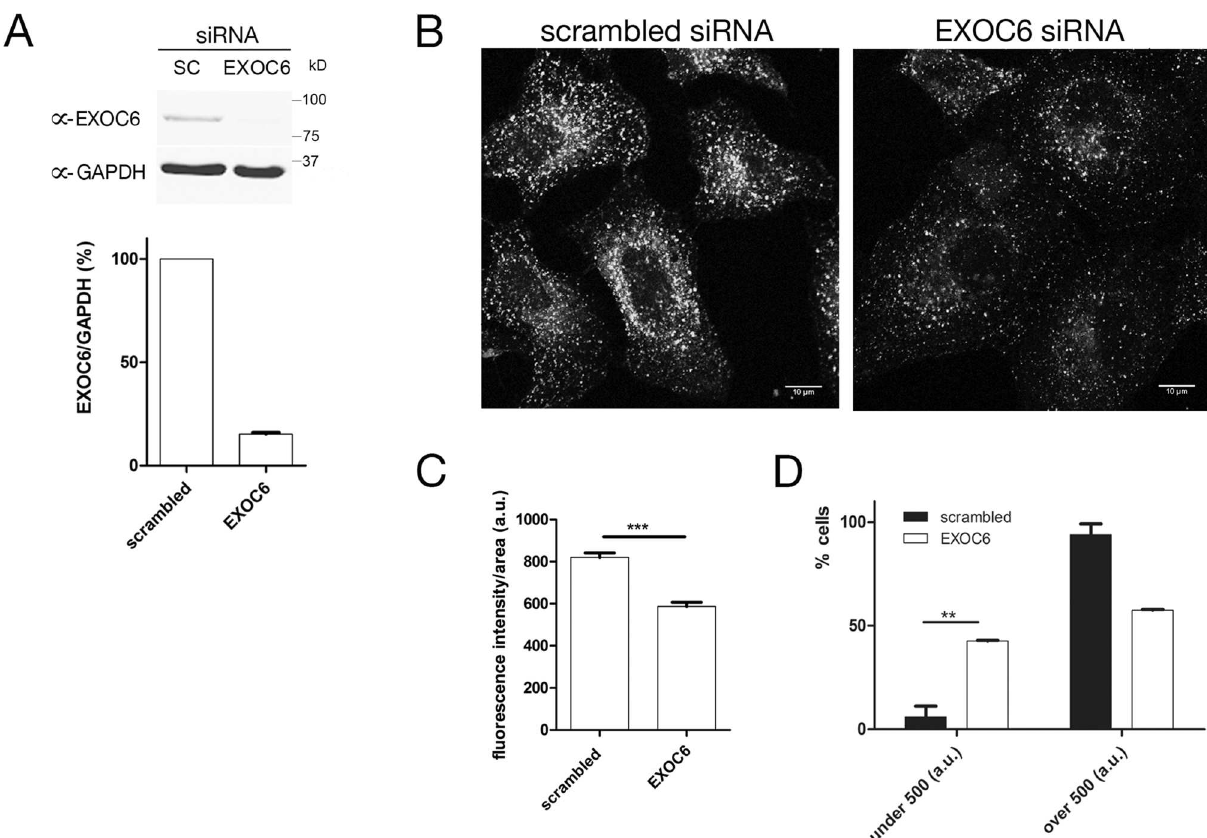
Fig 8. The exocyst functions in endocytosis in human cells. (A) Immunoblots of lysates preparedfrom HeLa cells treated with either scrambledor EXOC6 siRNA smart pools as shown in panel B, probedwith anti-EXOC6 or anti-GAPDHas indicated. Knockdownlevels of EXOC6 were quantified from 3 experiments of this type and are presentedas a ratio of EXOC6/GAPDH signals. (B) HeLa cells depicting transferrin uptake. Cells treated with either scrambled or EXOC6 siRNA were imaged after the uptake of labelledtransferrin (10 min). Representative fields of cells from 3 independentreplicates. (C) The fluorescence intensity of > 100 cells for each conditionwas determined using ImageJ and the data comparedusing an unpairedt test. *** P value < 0.0001. (D) The image intensity of > 100 cells of each condition were binnedinto two groups, those with a signal intensity > 500 arbitrary units, and those < 500. Knockdown of EXOC6 was found to significantly increasethe fraction of cells with a signal intensity < 500 ( ** P value < 0.01), consistent with a decreasein transferrin